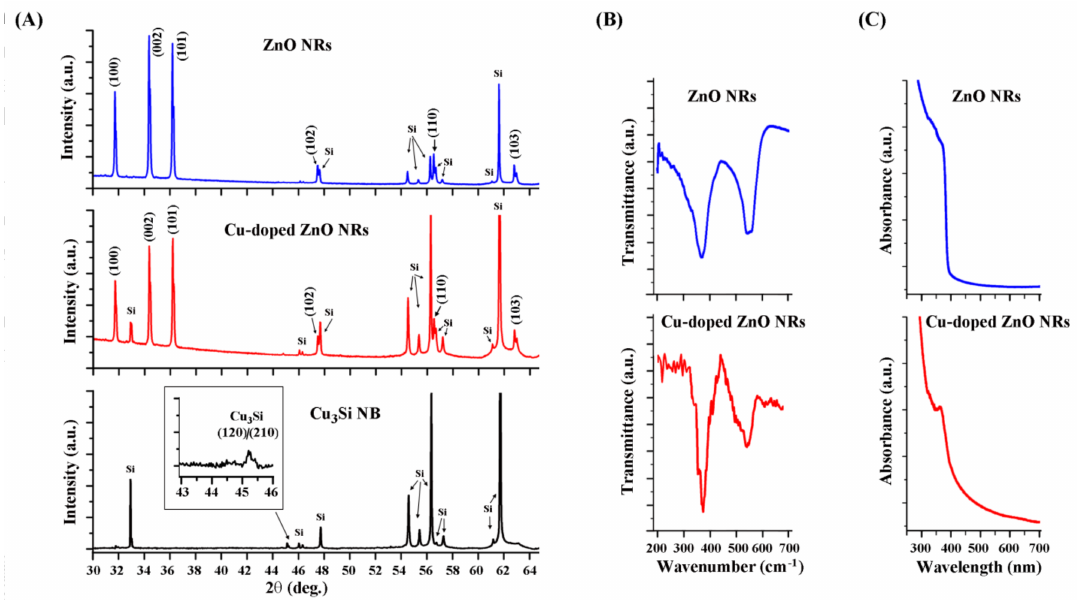
Figure 3. Diffraction and spectroscopic data of the NBs and NRs. ( A ) XRD data of Cu 3 Si NBs (black), Cu-doped ZnO NRs on Cu 3 Si NBs (red), and undoped ZnO NRs (blue); ( B ) ATR-FTIR spectra of undoped (blue) and Cu-doped (red) ZnO NRs; ( C ) UV–vis spectra of undoped (blue) and Cu-doped (red) ZnO